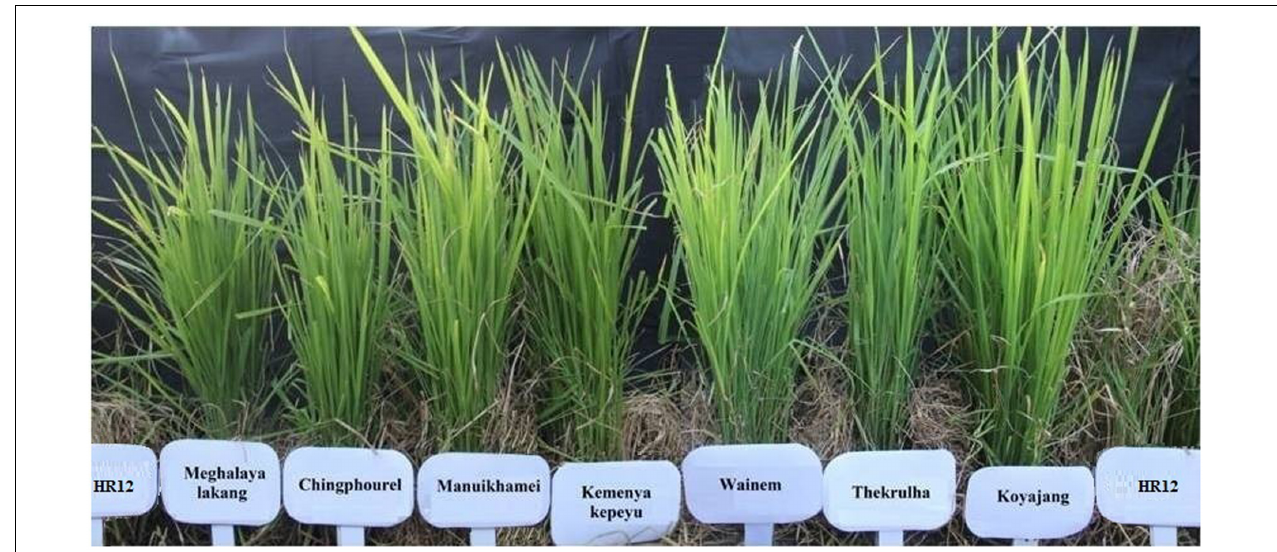
by phenotypic characters and SSR markers